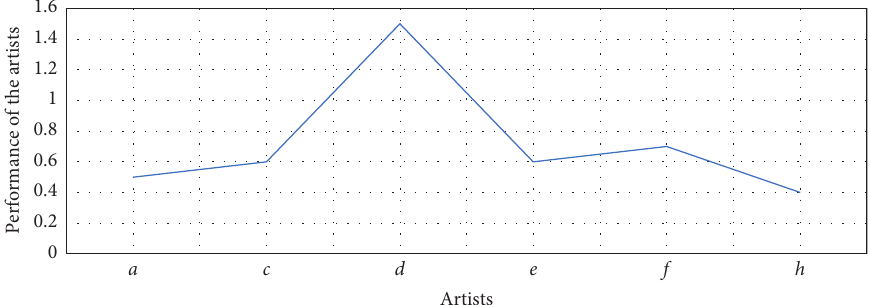
Figure 3: A graphical interpretation of Table